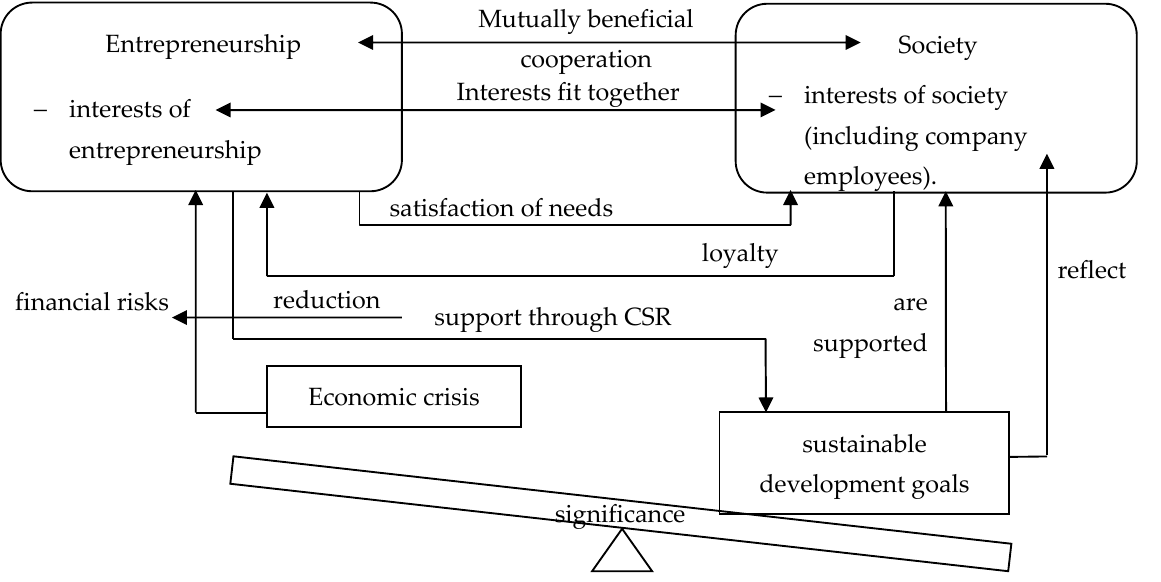
Figure 2. Socially-oriented approach to financial risk management in entrepreneurship. Source: authors.